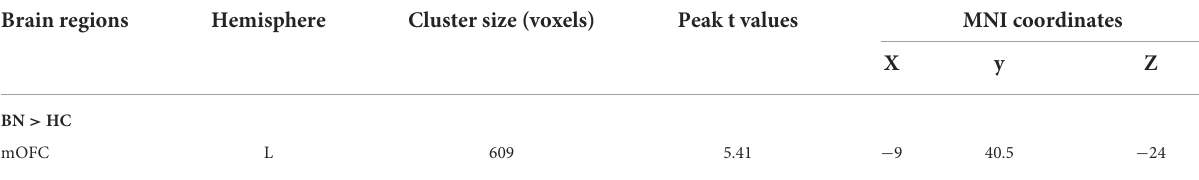
TABLE 2 Regional GMV abnormalities between bulimia nervosa patients and healthy controls.